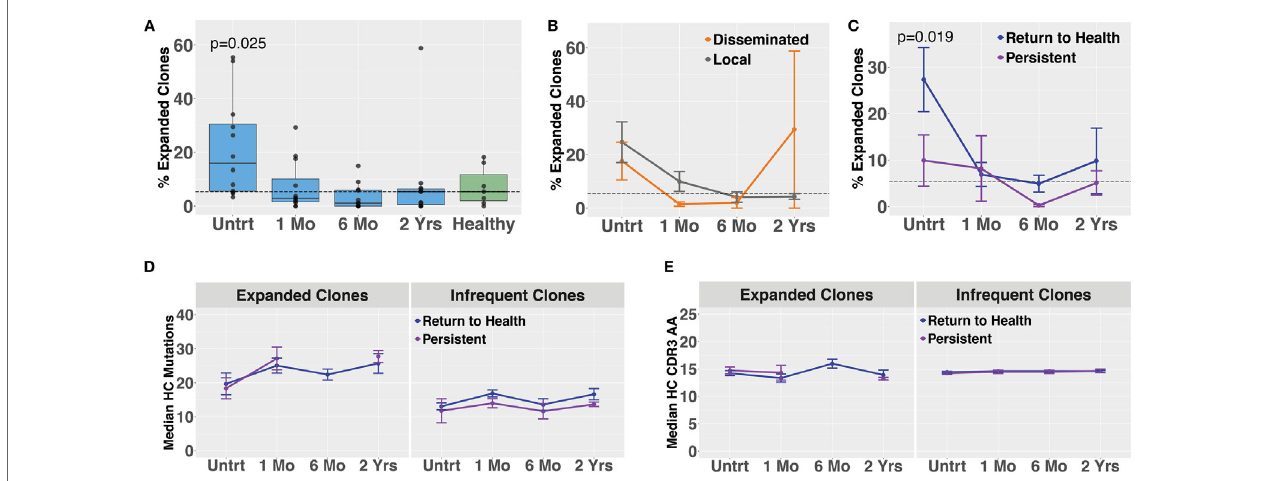
FigUre 3 | Bulk heavy-chain antibody repertoire sequencing shows increased clonal expansions in untreated Bb -infected humans. Total RNA from peripheral blood mononuclear cells was used for unique molecular identifier barcode-based sequencing of immunoglobulin heavy chains, yielding a mean of 49,293 full-length error-corrected VDJ sequences per subject. Percentage of expanded clones was analyzed across serial time points from the initial (untreated) presentation to 2 years following the completion of doxycycline treatment. (a) Degree of clonal lineage expansion was significantly increased in untreated Lyme disease. Percent clonality was calculated as the percent of clones that expanded to comprise more than 1% of the sequences at a given time point for each patient. (B) Degree of clonal lineage expansion was similar between patients with disseminated and local erythema migrans rash. (c) Patients with a shorter duration of symptoms (return to health) had significantly greater clonality as compared with those who experienced persistent symptoms following treatment. (D) The median number of somatic hypermutations and (e) median CDR3 amino acid lengths were similar between patient groups, for both expanded and infrequent clones. P values are from ANOVA with Dunnett’s (a) or Sidak’s (c) multiple comparisons tests. Dashed lines represent the median value of healthy controls, and error bars represent the